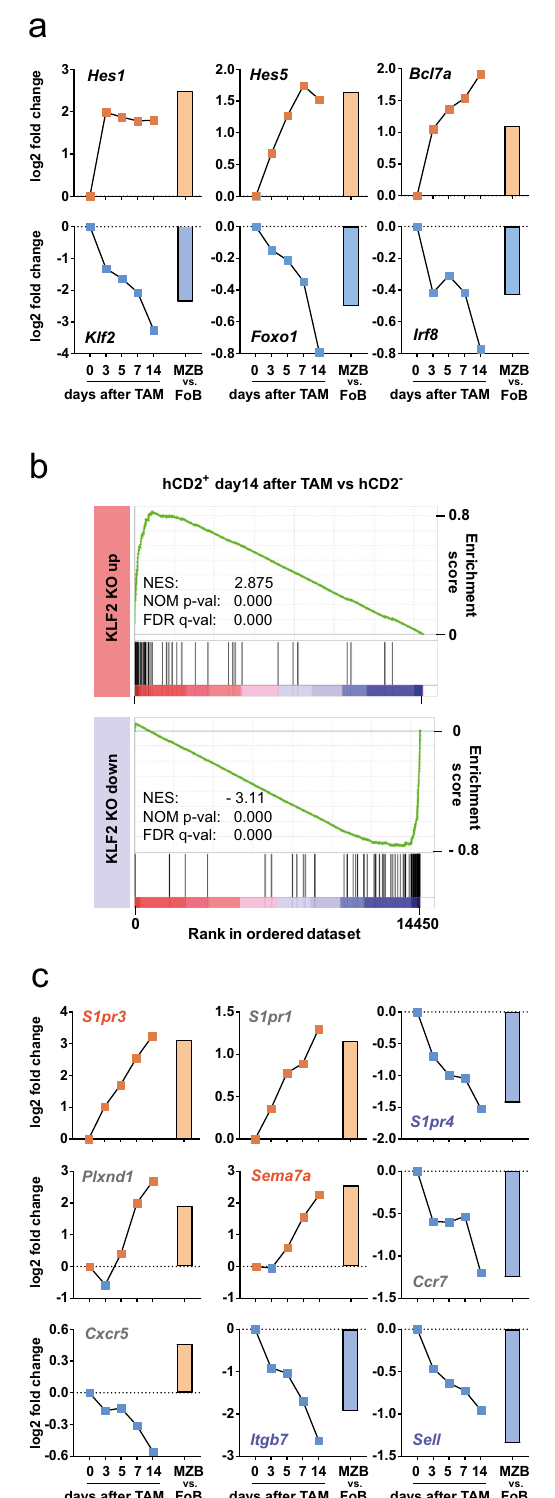
(Fig. 7c). In both systems the upregulation of CD21 protein and Cr2 mRNA was very fast, while the modulation of CD23 ( Fcer2a ) and CD1d ( Cd1d1 ) expression was delayed. These data are in line with previous observations suggesting that Cr2 is a direct Notch2 target gene 18,47,48 . In sum, our data show that FoB cells can transdiffer- entiate into MZB cells in immunocompetent mice within a time window of 14 days. The similar temporal regulation of CD21, CD1d, NATURE COMMUNICATIONS| (2021) 12:1111